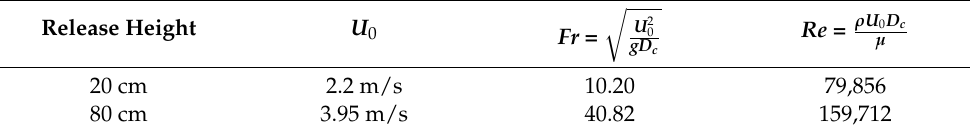
Table 2. Water entry